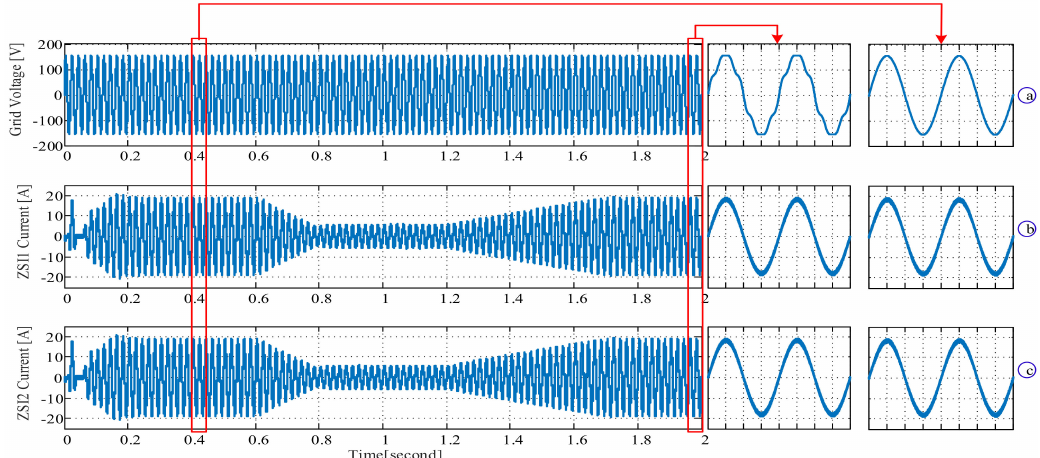
Figure 12. ( a ) Grid voltage, V g , ( b ) current injected to the grid by ZSI 1, i 1 , ( c ) current injected to the grid by ZSI 2, i 2 .